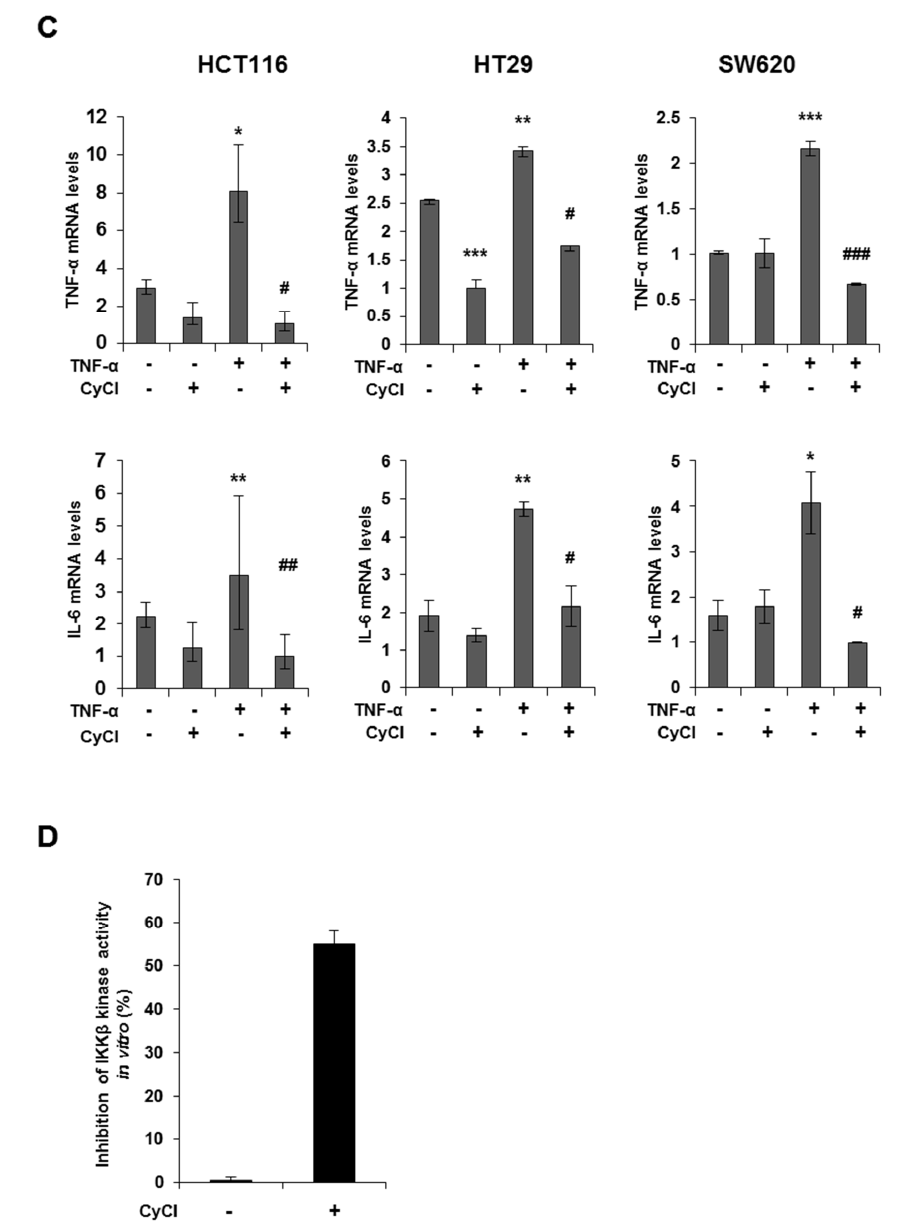
Figure 4. CyCl suppresses the nuclear factor kappa-light-chain-enhancer of activated B cells (NF- κ B) signaling pathway in colon cancer cells. ( A ) HCT116, HT29, and SW620 cells were transiently transfected with NF- κ B-Luc plasmids for 24 h and treated with 0, 25, and 50 µ M of CyCl for 24 h. Cell extracts were harvested, and luciferase assays were performed. ( B ) HCT116, HT29, and SW620 cells were treated with tumor necrosis factor-alpha (TNF- α ) and 50 µM of CyCl and incubated for 24 h. Protein extracts were separated by SDS-PAGE, and Western blot analysis was conducted for the expressions of p-inhibitor of kappa B alpha (I κ B α ), I κ B α , p-inhibitor of nuclear factor kappa-B kinase subunit alpha/beta (IKK α / β ), IKK α , IKK β , p65, and p50 protein. ( C ) HCT116, HT29, and SW620 cells were treated with TNF- α and 50 µM of CyCl and incubated for 24 h. RNA was extracted from the cells and mRNA expression of TNF- α and IL-6 was measured by qRT-PCR analysis. ( D ) The inhibitory e ff ect of CyCl (10 µ M) on IKK β kinase activity in vitro was analyzed by the SelectScreen ™ Biochemical Kinase Profiling Service. * p < 0.05, ** p < 0.01, and *** p < 0.001, significantly di ff erent compared with control; # p < 0.05, ## p < 0.01, and ### p < 0.001, significantly di ff erent compared with TNF- α -treated